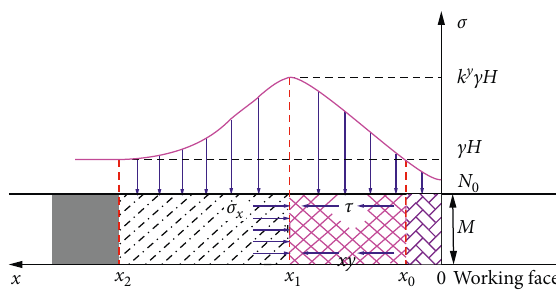
Figure 5: Distribution characteristics of elastic and plastic zones in coal